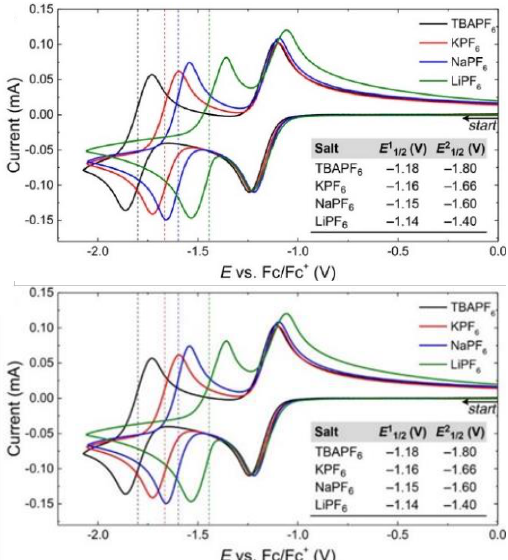
Figure 11. ( Top ) Redox chemistry of 4 − benzoylpyridinium. ( Bottom ) Cyclic voltammograms of 4 − benzoylpyridinium (5.0 mM in acetonitrile, 100 mV/s scan rate) in various supporting electrolytes (0.50 M in each case). Reproduced with permission from Hendriks et al. [160], copyright American Chemical Society 2017.